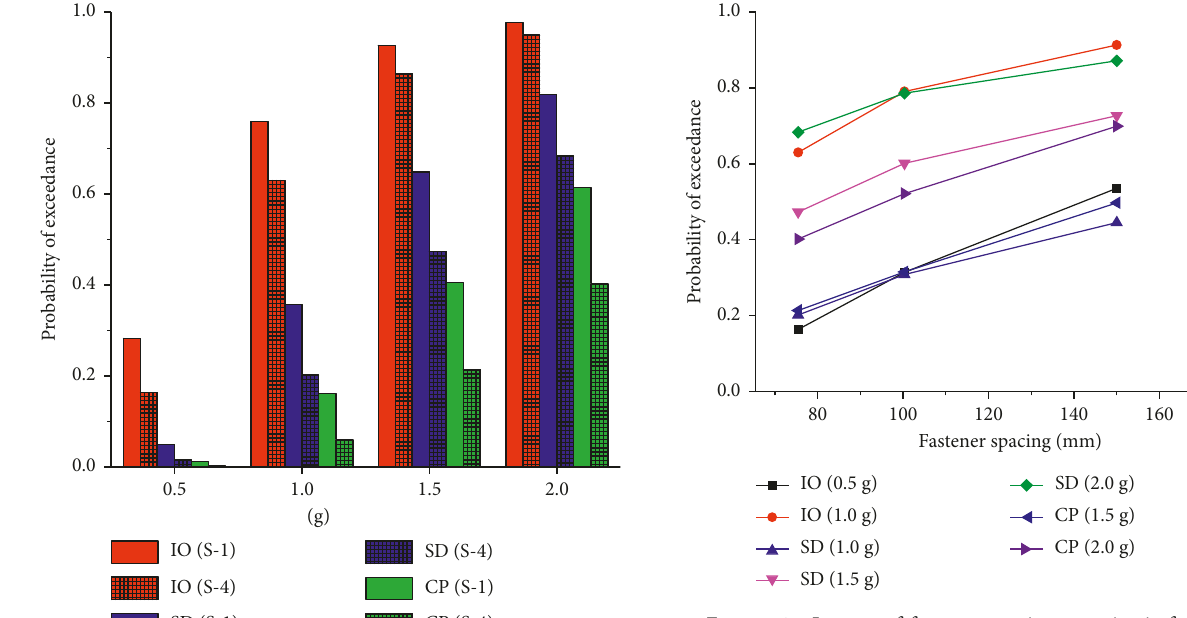
Figure 15: Impact of fastener spacing on seismic